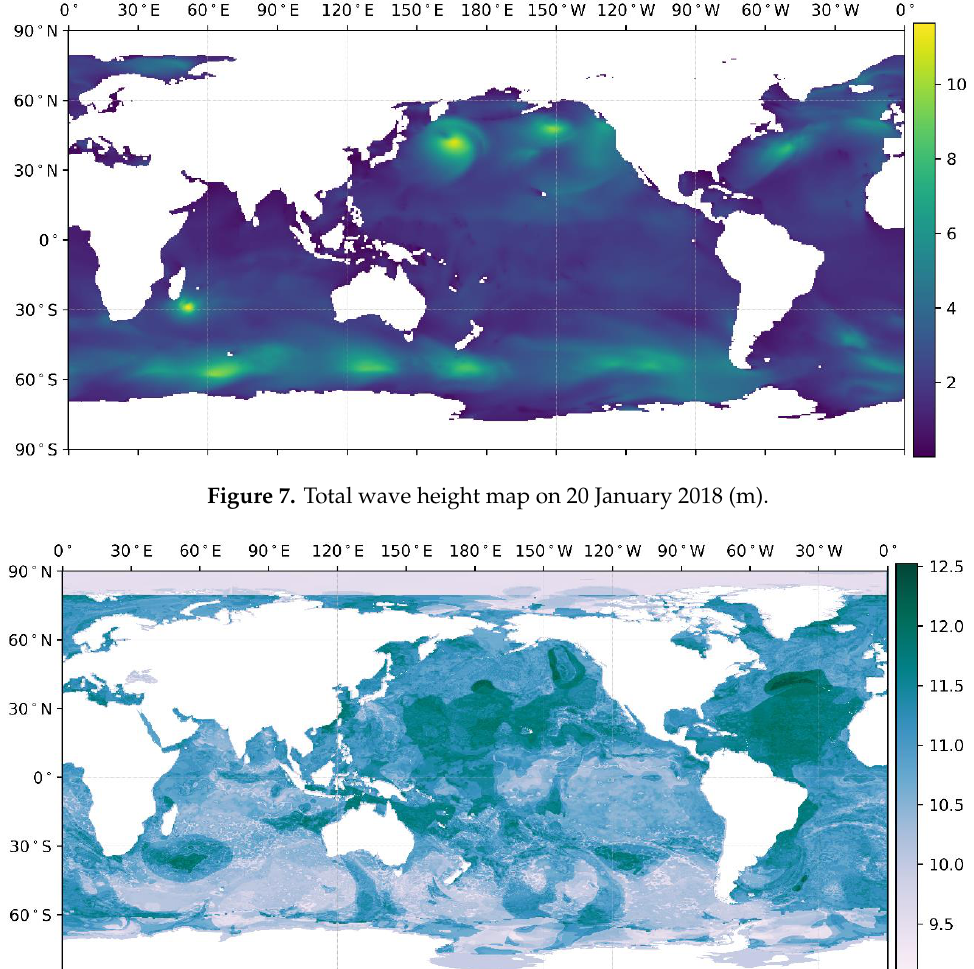
Table 11. Simulation results. Method